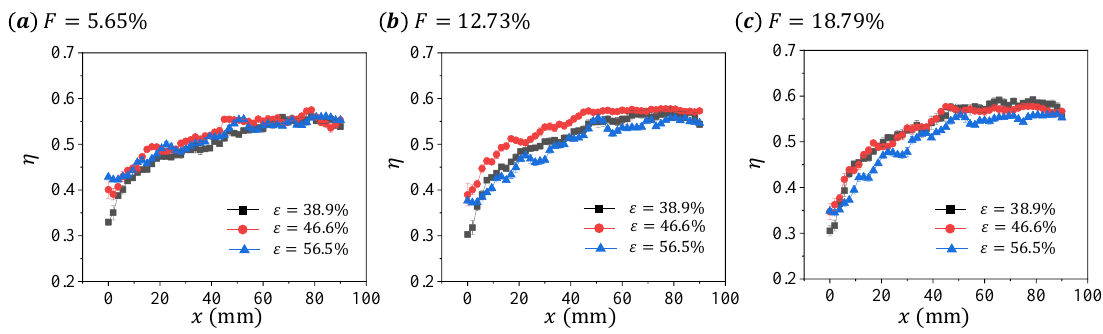
Figure 7. The distribution of cooling efficiency η on the central line of the test sample for different porosity ε at same blowing ratio F : ( a ) F = 5.65%, ( b ) F = 12.73%, and ( c ) F = 18.79%.